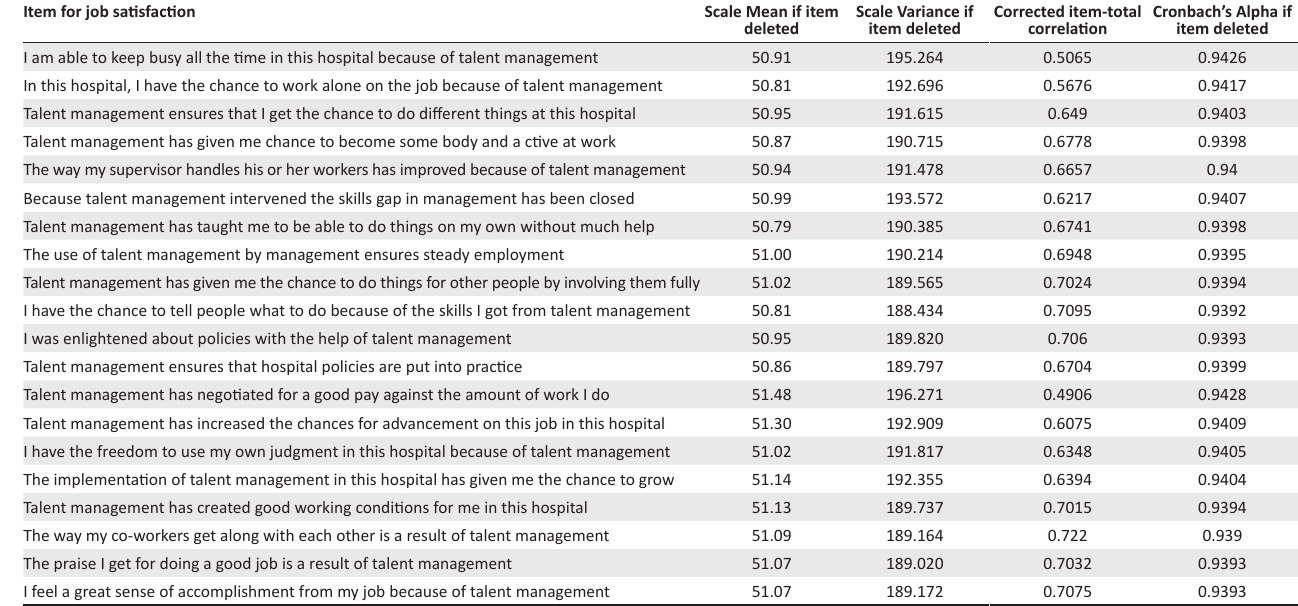
TABLE 1: Item-Total Statistics for Minnesota Job satisfaction